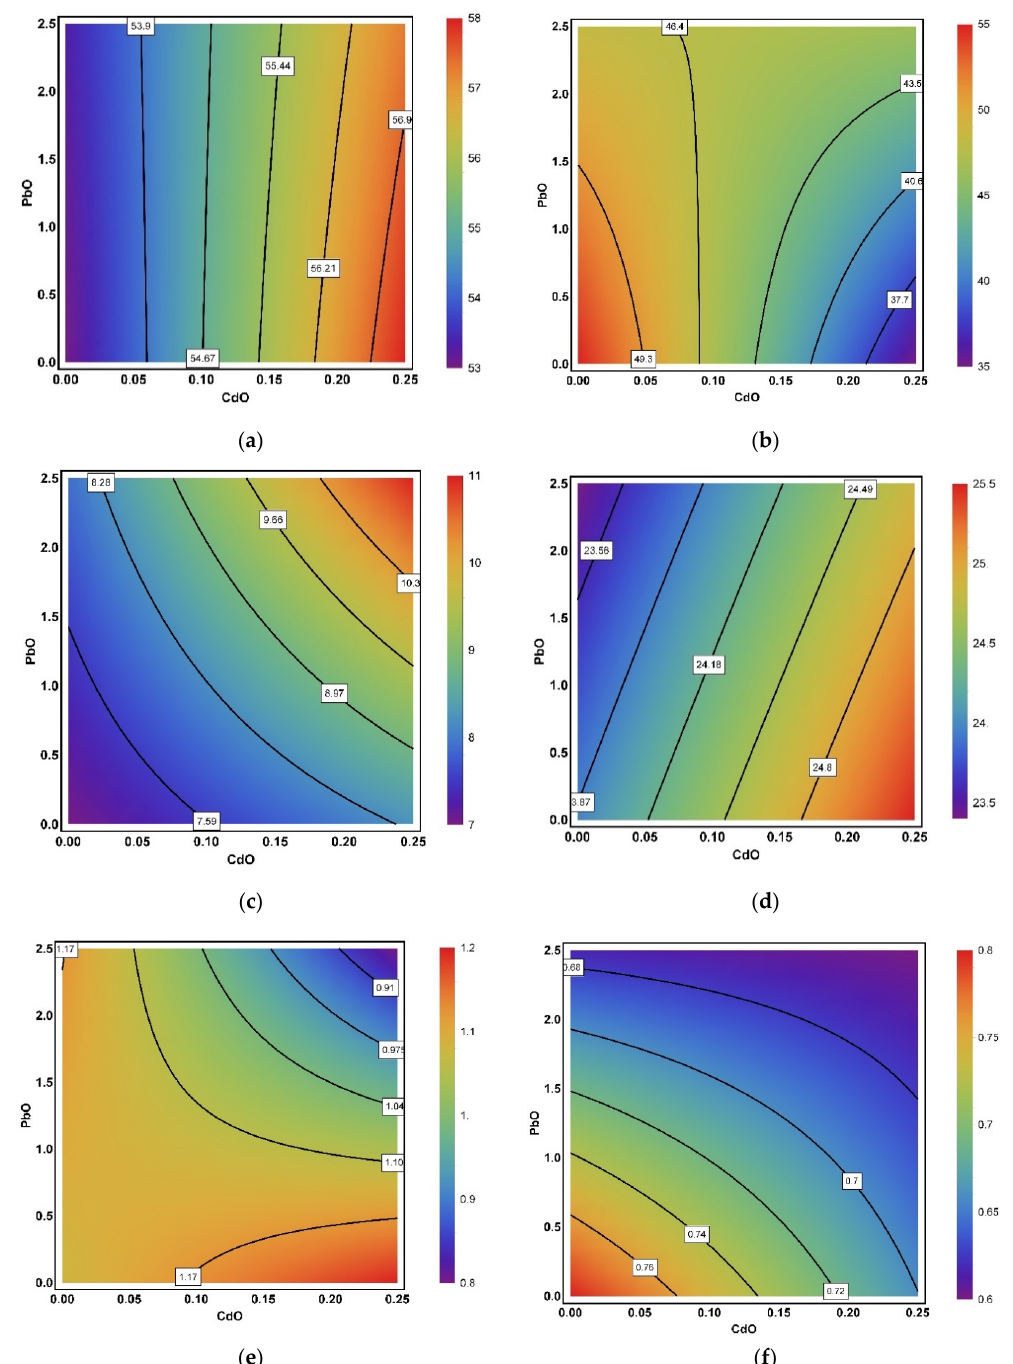
Figure 10. Examples of isobolgrams illustrating variations in the type of combined action produced by CdO and PbO nanoparticles on myocardial contractility: ( a ) active tension in trabeculae at L = L MAX (single-factor action of cadmium, changing to contradirectionality at high doses), ( b ) active tension in papillary muscles at L = L MAX (from additivity at low doses through single-factor action of cadmium at low doses of lead to contradirectionality at high NP doses), ( c ) passive tension in trabeculae at L = L MAX (superadditivity), ( d ) maximal normalized rate in papillary muscles at L = 0.9L MAX (opposite actions), ( e ) force–velocity relationships in trabeculae at P = 0.7P 0 (complex picture from contradirectionality at low doses to additivity at high NP doses), ( f ) maximal shortening velocity of papillary muscles at P = 0.8P 0 (additivity, changing to subadditivity). The axes plot doses as fractions of actual value; numbers on the isoboles indicate the level of the corresponding effect).